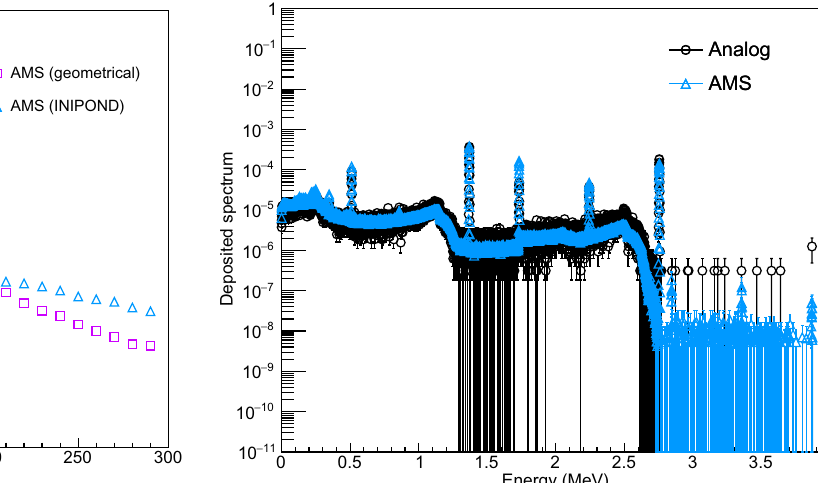
Fig. 7. FOM comparison in the Water box. Fig. 9. Deposited spectrum in the HPGe detector.